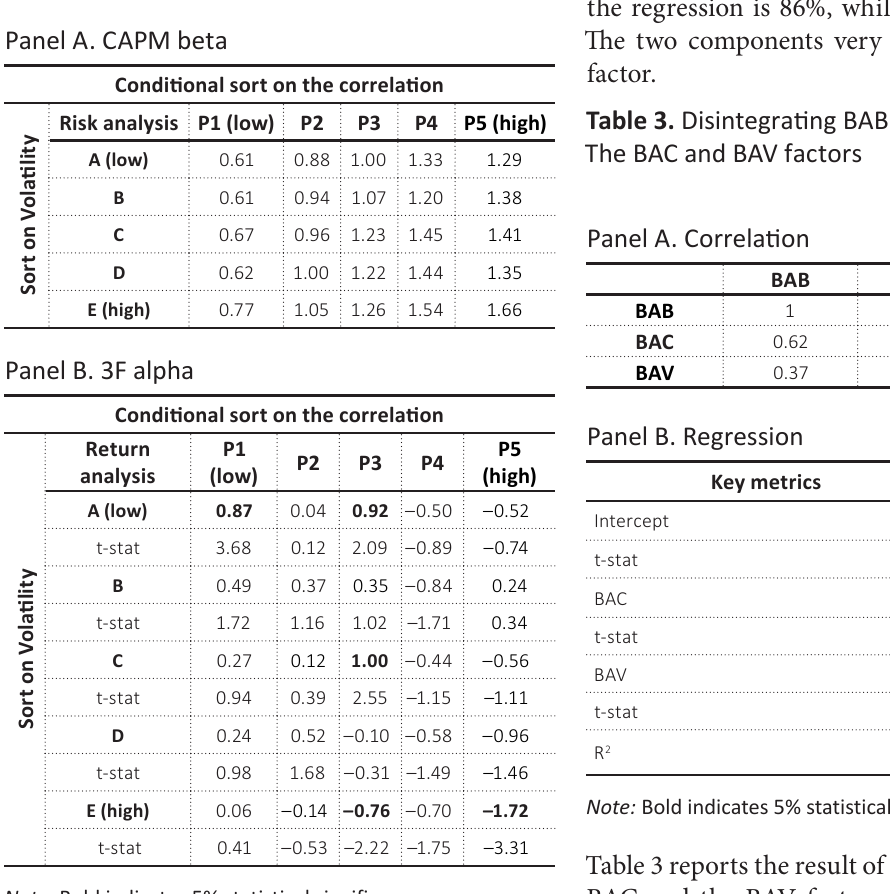
Table 2. Correlation vs volatility: Risk-adjusted returns and